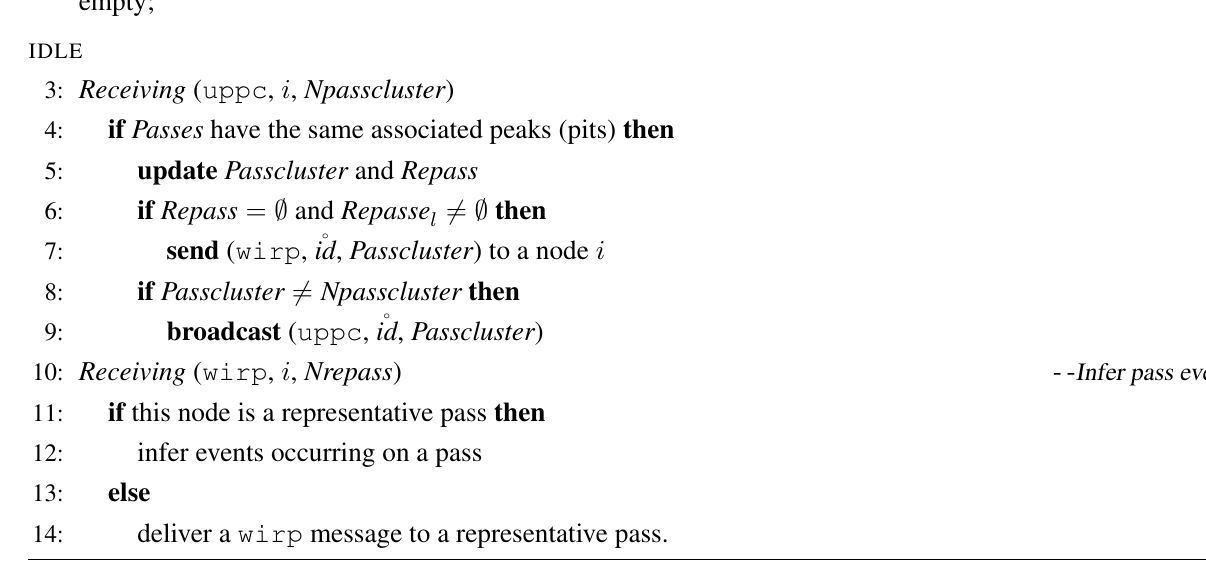
Algorithm 5 Monitoring events occurring on